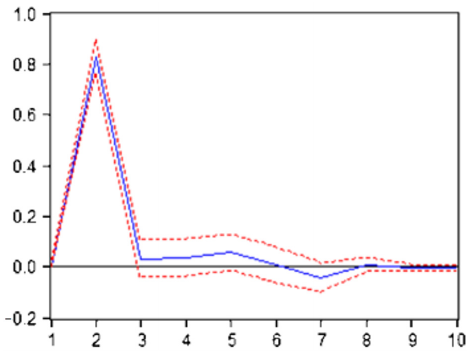
Figure 5. The impulse response of SHFE to COMEX copper yield.